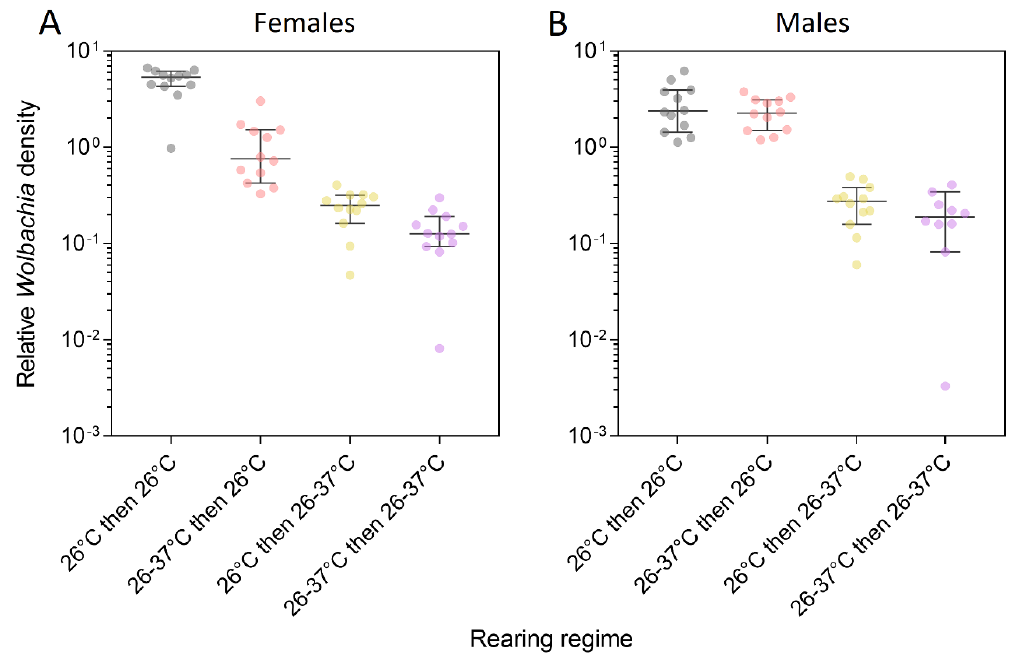
Figure 5. Relative Wolbachia density of w Mel-infected male and female Ae. aegypti that were reared under different temperature regimes across two generations. Mosquitoes were reared at 26 °C in both generations (gray dots), 26 – 37 °C in both generations (purple dots), 26 – 37 °C in the first generation and 26 °C in the second generation (red dots) or 26 °C in the first generation and 26 – 37 °C in the second generation (yellow dots). Error bars are medians and 95% confidence intervals.